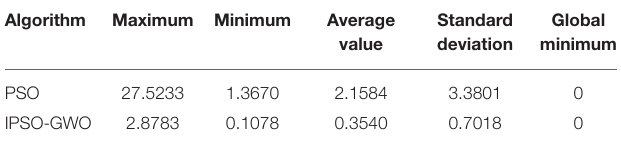
TABLE 4 | Bukin function test results.